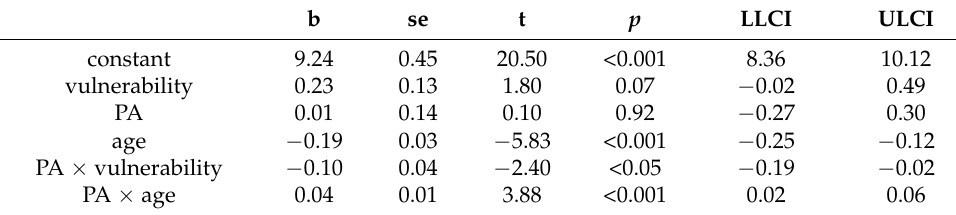
Figure 4. Double moderation model in which age and socioeconomic vulnerability are considered as moderators. Table 7. Conditional effect of physical activity on subjective well-being, moderated by age and socioeconomic vulnerability. Table 6. Regression analysis of SWB on PA, considering the moderating effect of age and